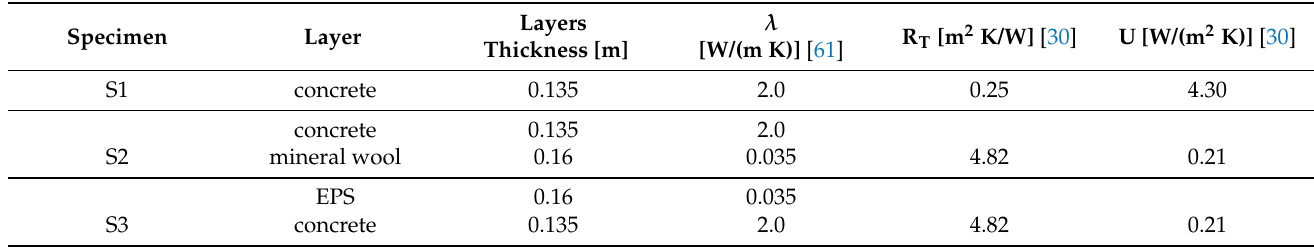
Table 2. Specimen description and thermal